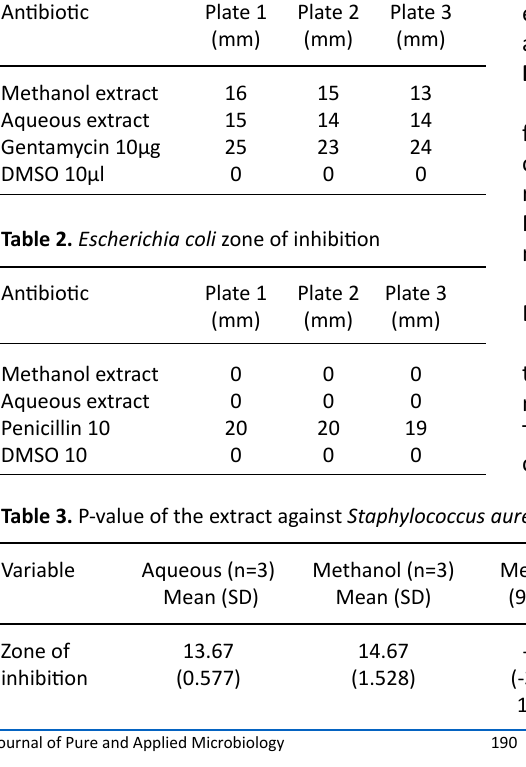
Table 1. Staphylococcus aureus zone of inhibition Antibiotic